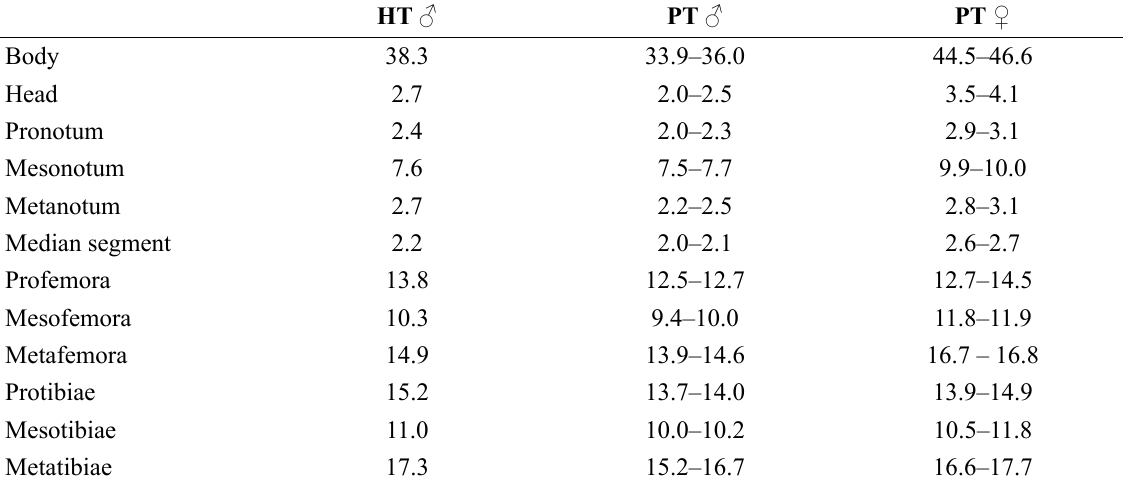
Table 4. Measurements (mm) of Otraleus elizabethae sp. nov. HT = holotype; PT =